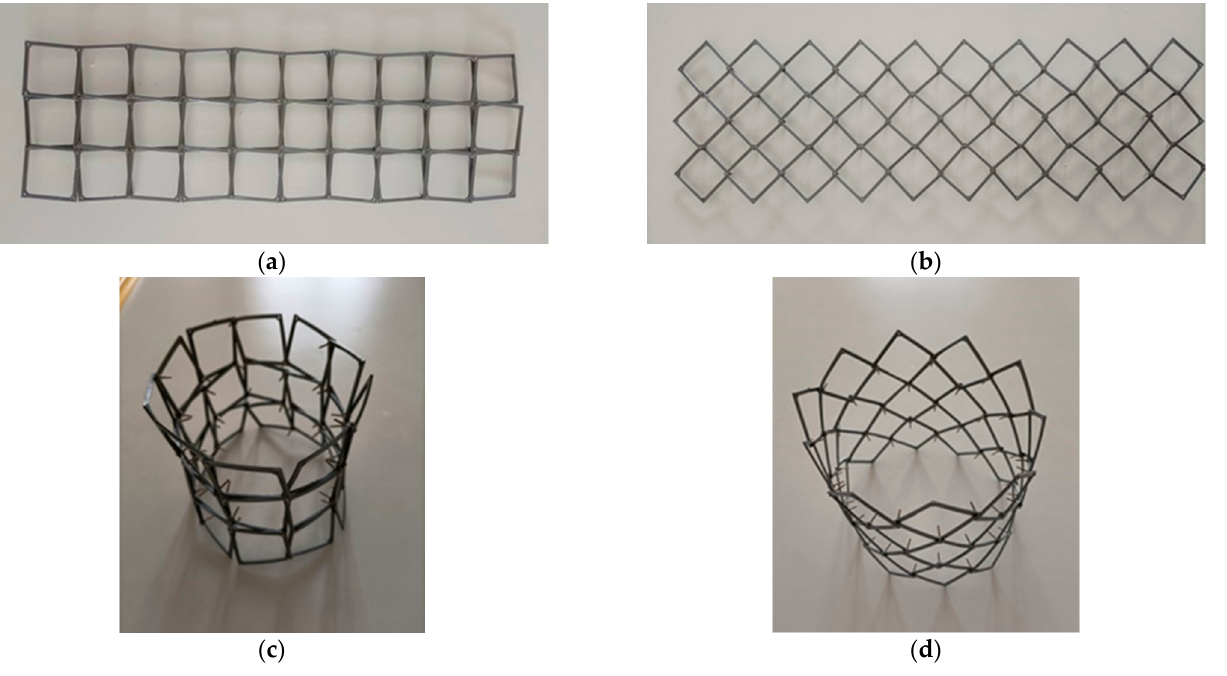
Figure 13. Planar structure of 10 × 3 square hard polymer frames ( a , b ) and a tubular structure after they are connected ( c , d ) in the closed and open positions.